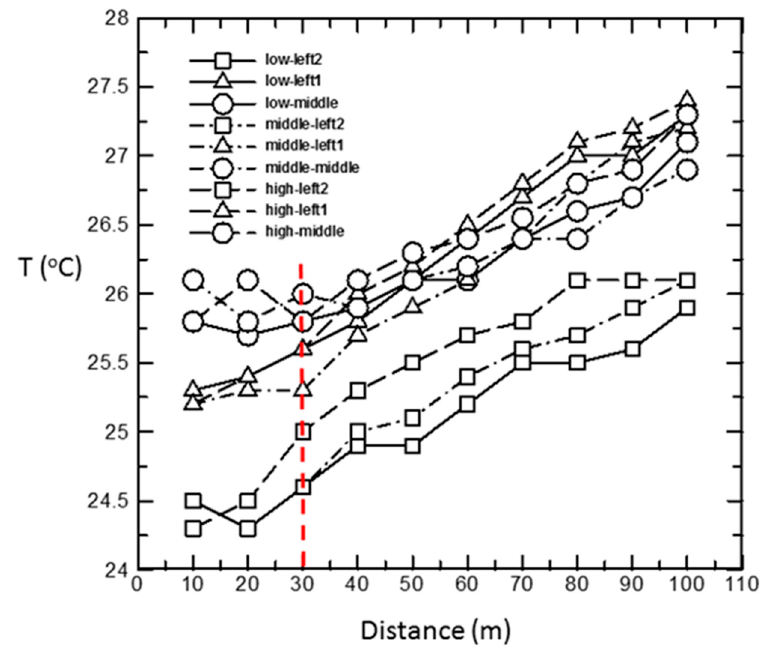
Figure 10. temperature distribution in water-pad layer house, Dalin,